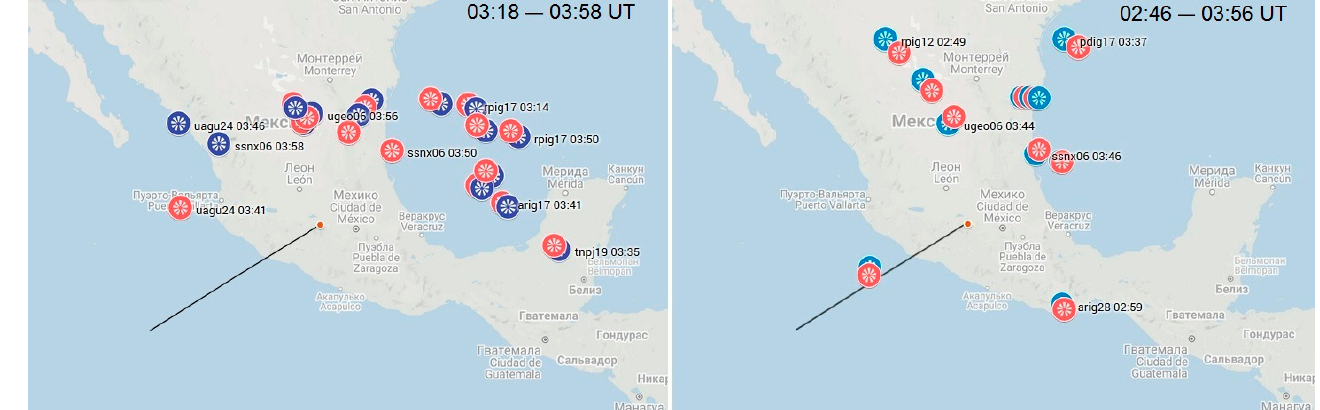
Figure 16. Map of sub-ionospheric points at which N-form ( left ) and И -form ( right ) disturbances were detected. Red circles stand for positive and blue circles for negative dIv deviations in N- and И -form deviations.